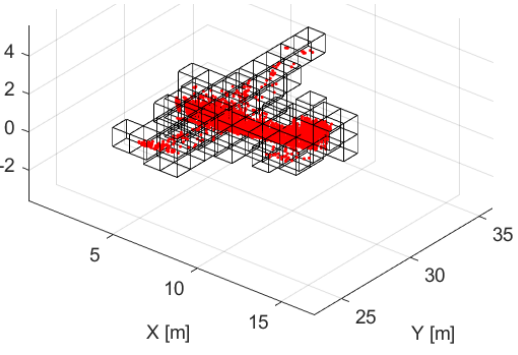
Figure 5. Measuring the volume of the reconstruction: the space is decimated with cubes, and the volume is represented by the number of cubes occupied by the reconstruction.